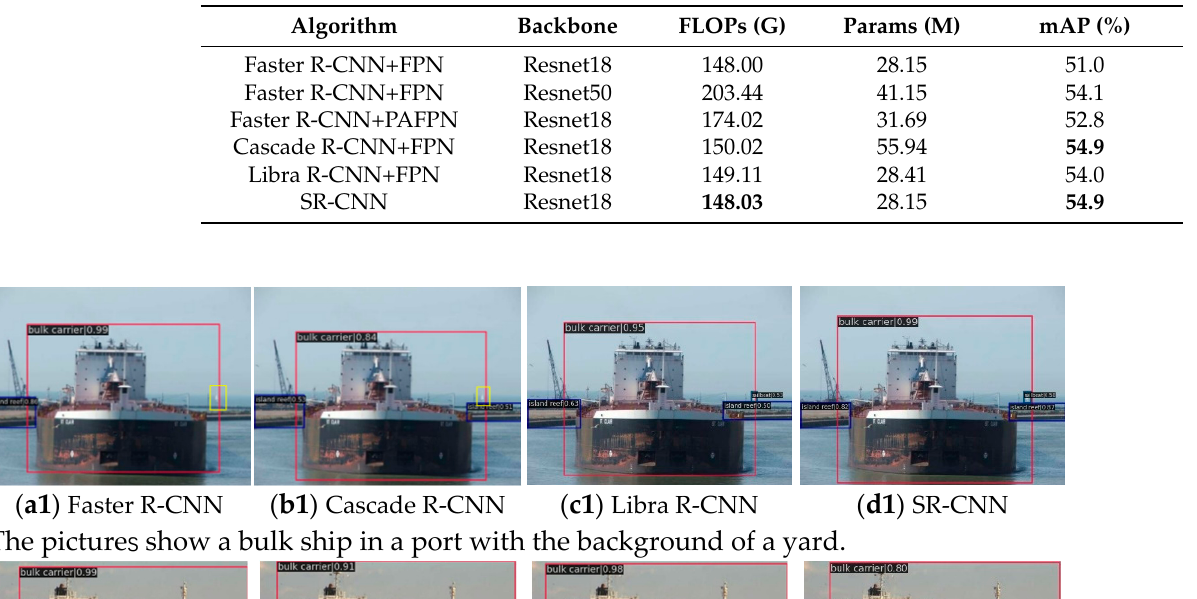
Table 5. Performance comparison of different detection algorithms.